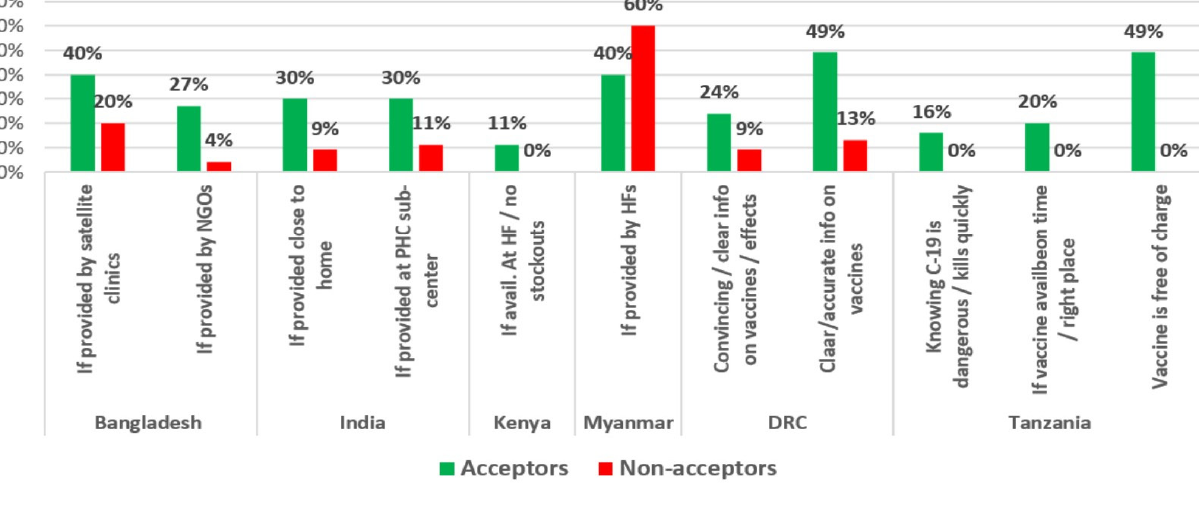
Figure 9. Perceived access to COVID-19 vaccines by country.